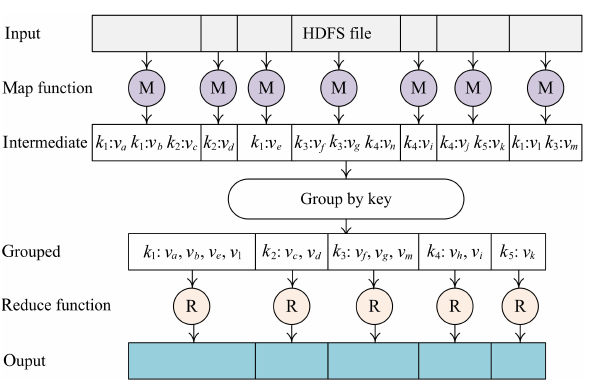
Fig. 1 MapReduce model.